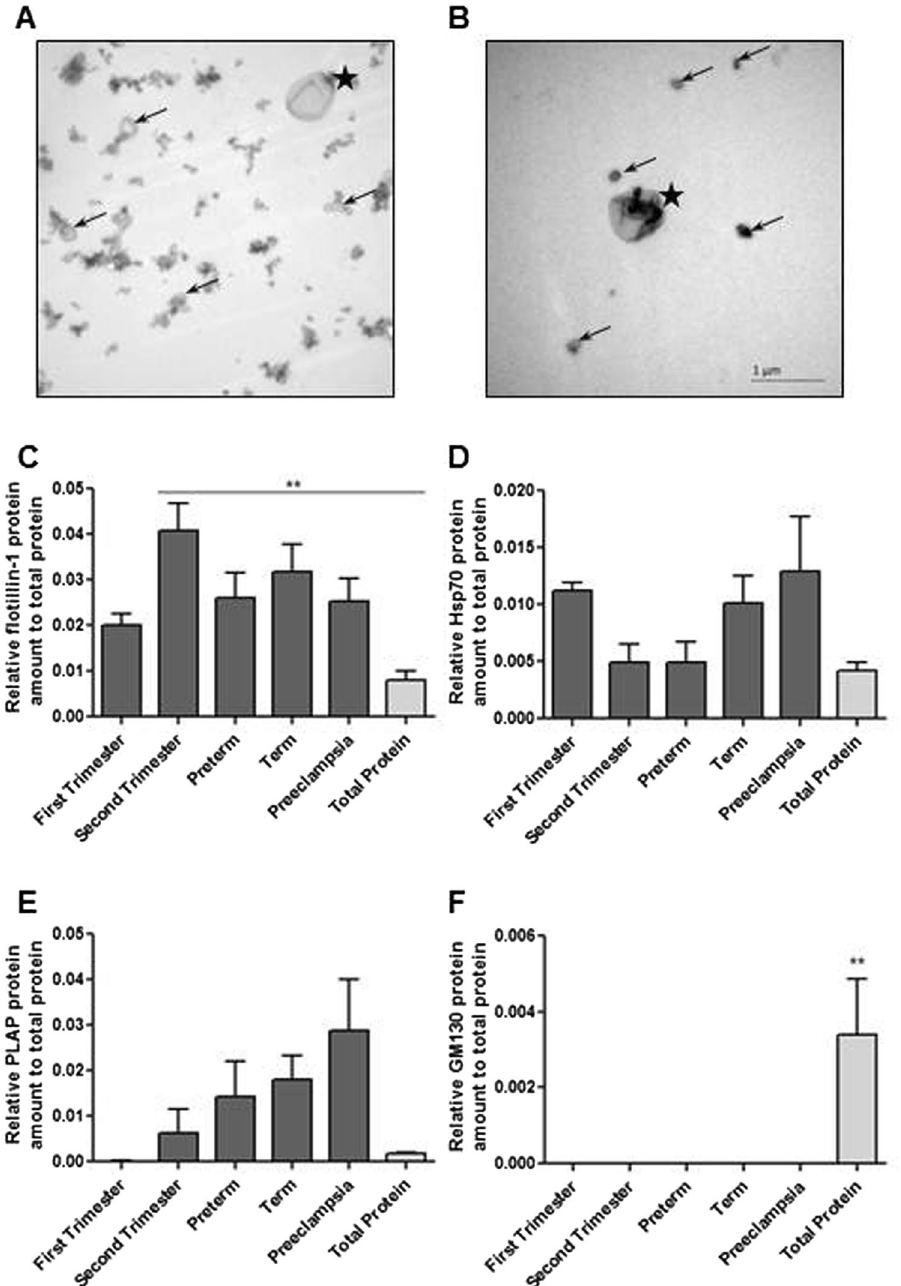
Figure 1. Purity of EVs was assessed using low magnification TEM. ( A ) EV preparation prior to and ( B ) following qEV exclusion column. Images taken at 19,000X magnification. Arrows = exosome, * = micro- vesicles. ( C – F ) Additional characterization of the EVs was performed by Western blotting for EV-specific markers, Flotilin-1 and Hsp70, and for placenta specific marker-PLAP. Purity of preparations was further validated with GM130 antibody. Densitometry analysis for ( C ) Flotilin-1, ( D ) Hsp70, ( E ) PLAP and ( F ) GM130 are